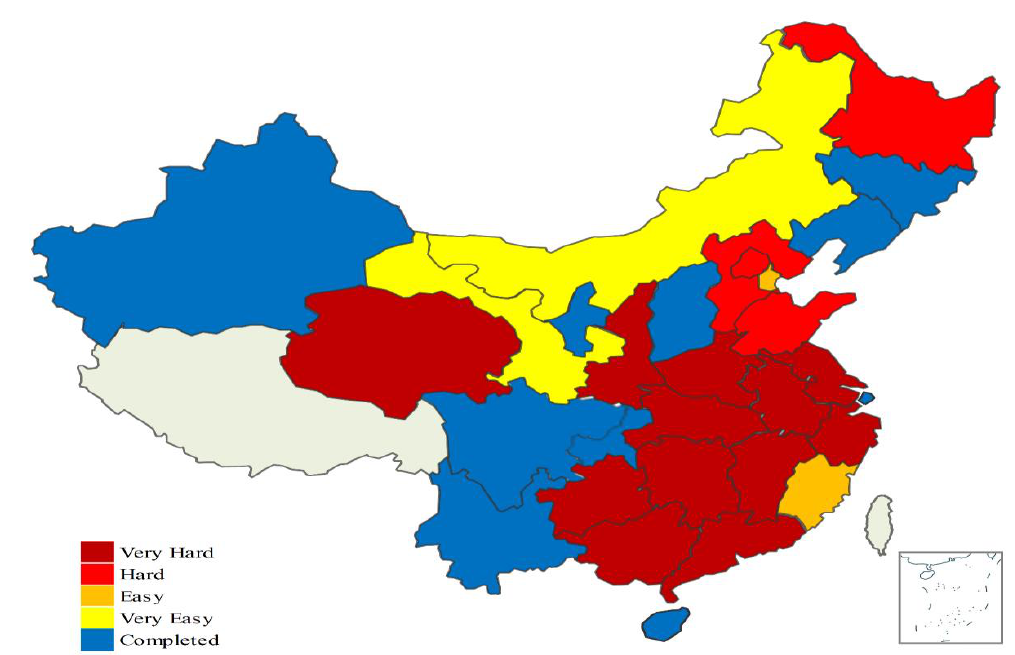
Figure 3. RPS completion potential brought by single approach of flexibility modification.